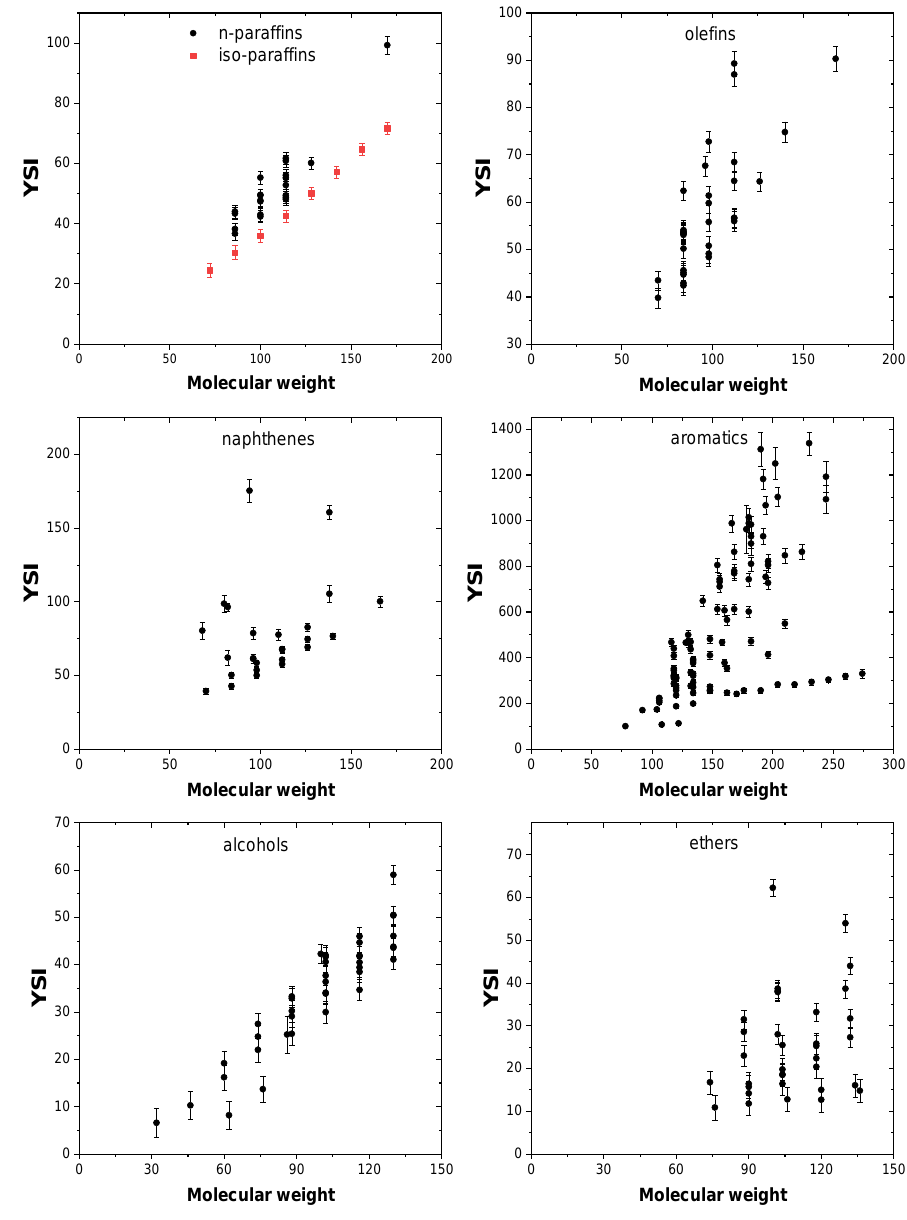
Figure 11. Effect of molecular weight on YSI .